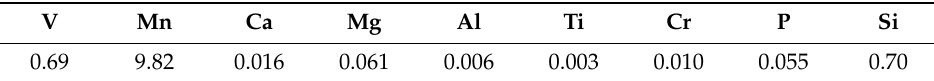
Table 3. Concentrations of V and the main impurities contained in mother liquor after vanadium precipitation (g · L − 1 ).